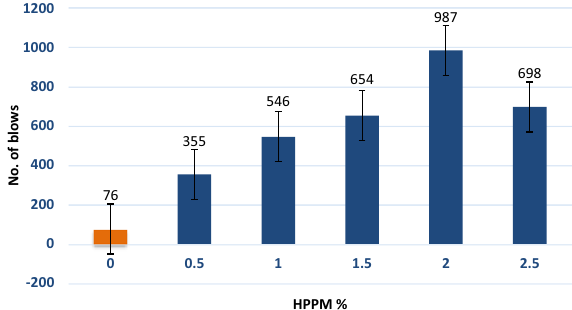
Figure 10. Influence of HPPM incorporation on Impact